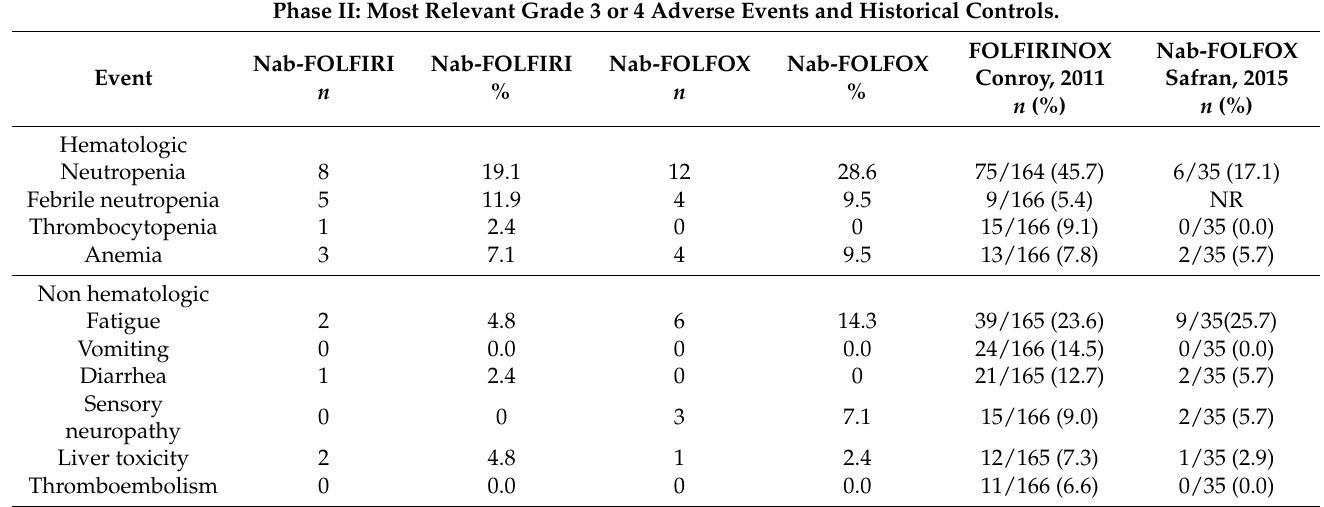
Table 5. Most relevant grade 3 or 4 adverse events and historical controls. NR: not reported. Phase II: Most Relevant Grade 3 or 4 Adverse Events and Historical